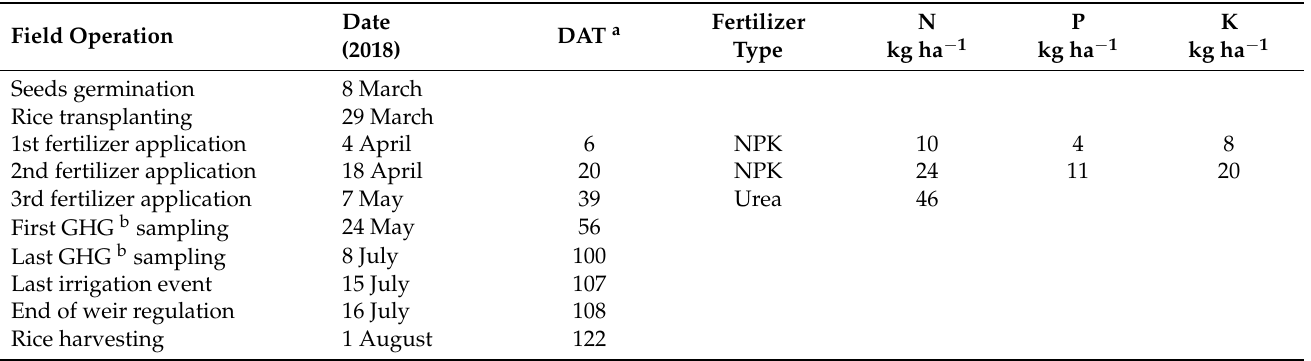
Table 1. Field management practices, fertilizer type, and fertilizer application rate (N = nitrogen, P = phosphorus, K = potassium) in the